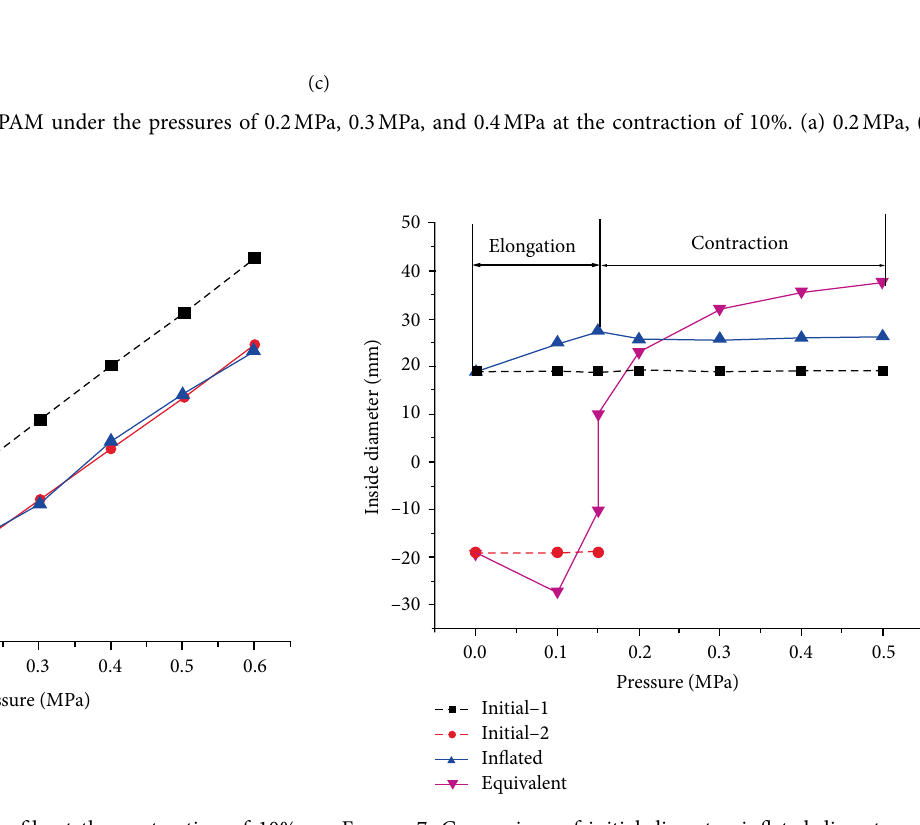
Figure 6: Static force-pressure profile at the contraction of 10% obtained with the geometrical model, the FEM model and the experiment (isometric condition).